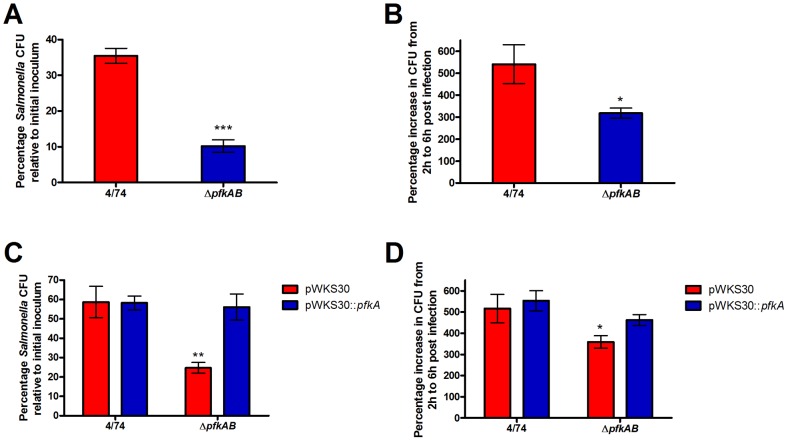
Glycolysis is important but not essential for the invasion and intracellular replication of HeLa cells with S. Typhimurium.(A) Invasion assay of S. Typhimurium 4/74 parental and ΔpfkAB (JH3486) strains in HeLa cells (B). Intracellular replication assays of S. Typhimurium 4/74 parental and ΔpfkAB (JH3486) strains during infection of HeLa cells. The chart shows the percentage replication of bacteria between 2 h and 6 h. (C) Complementation of invasion of the S. Typhimurium ΔpfkAB strain in HeLa cells. (D) Complementation of intracellular replication of the S. Typhimurium ΔpfkAB strain in HeLa cells. Each bar represents the statistical mean from three biological replicates and the error bars represent the standard deviation. (The significant differences between the parental 4/74 strain (A, B), or the 4/74 (pWKS30) strain (C, D) and the mutant strains are shown by asterisks, *p<0.05. **p<0.01, and ***p<0.001).